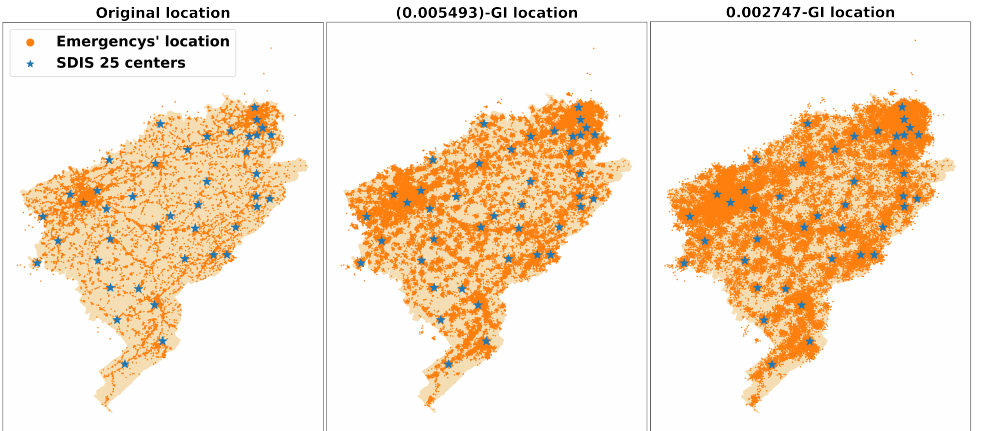
Figure 3. Emergency locations and SDIS 25 centers throughout the Doubs region: original data (left-hand plot), (cid:101) = 0.005493-GI data (middle plot), and (cid:101) = 0.002747-GI data (right-hand plot).